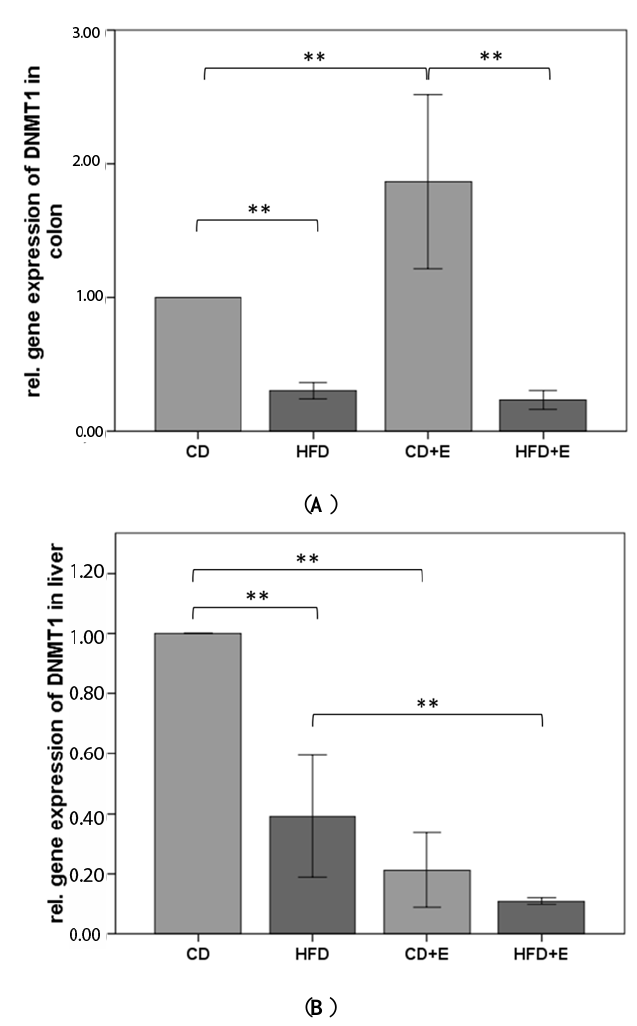
Figure 3. Relative gene expression of Dnmt1 in colon ( A ) and liver ( B ) of C57BL/6J male mice ( n = 15). Gene expression data were calculated relative to CD-data and normalized to the house keeping gene GAPDH. The error bar represents a 95% confidence interval. (CD = control diet; HFD = high fat diet; CD + E = control diet plus vitamin E; HFD + E = high fat diet plus vitamin E; ** p -value ≤